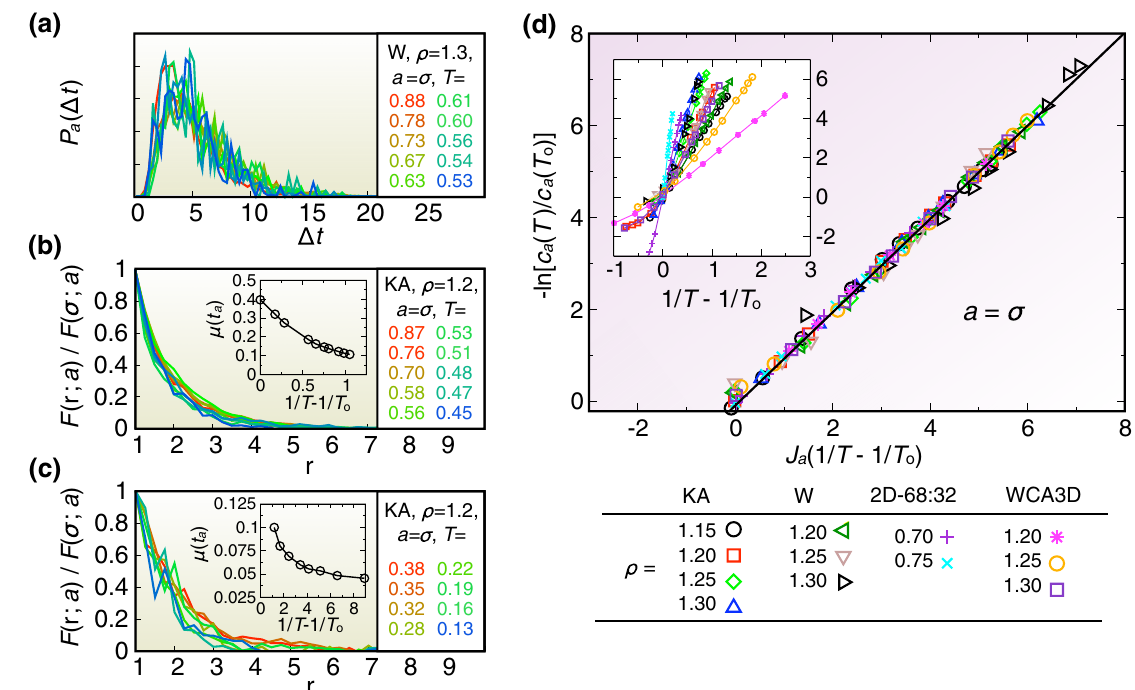
’ 0 : 88 . (b) Excess mobility o c a for the 12 systems considered. The inset shows